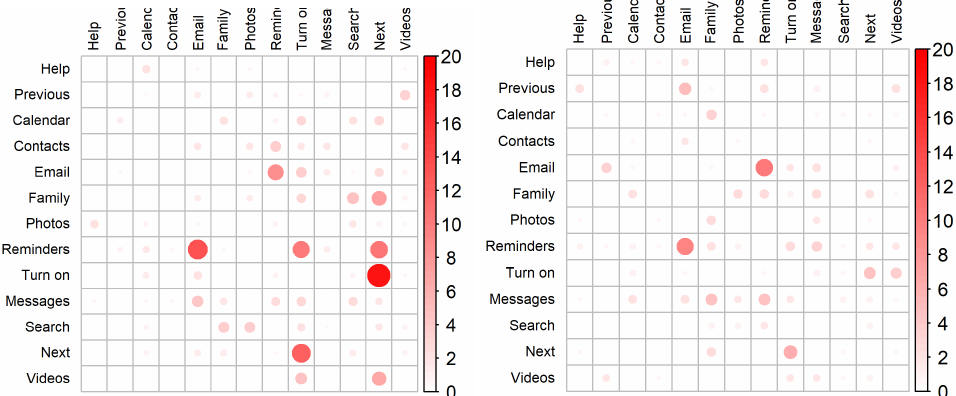
Figure 5. Confusion matrices for the best classifiers in each session illustrating the average recognition results across all participants. BAG classifier was considered for the first session ( left ), while LR classifier was considered for the second ( right ). The matrix rows represent the word instances submitted for recognition, while its columns represent the corresponding recognized words.